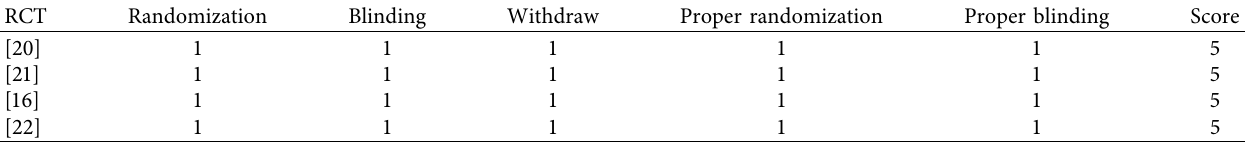
Table 2: Quality of the selected studies